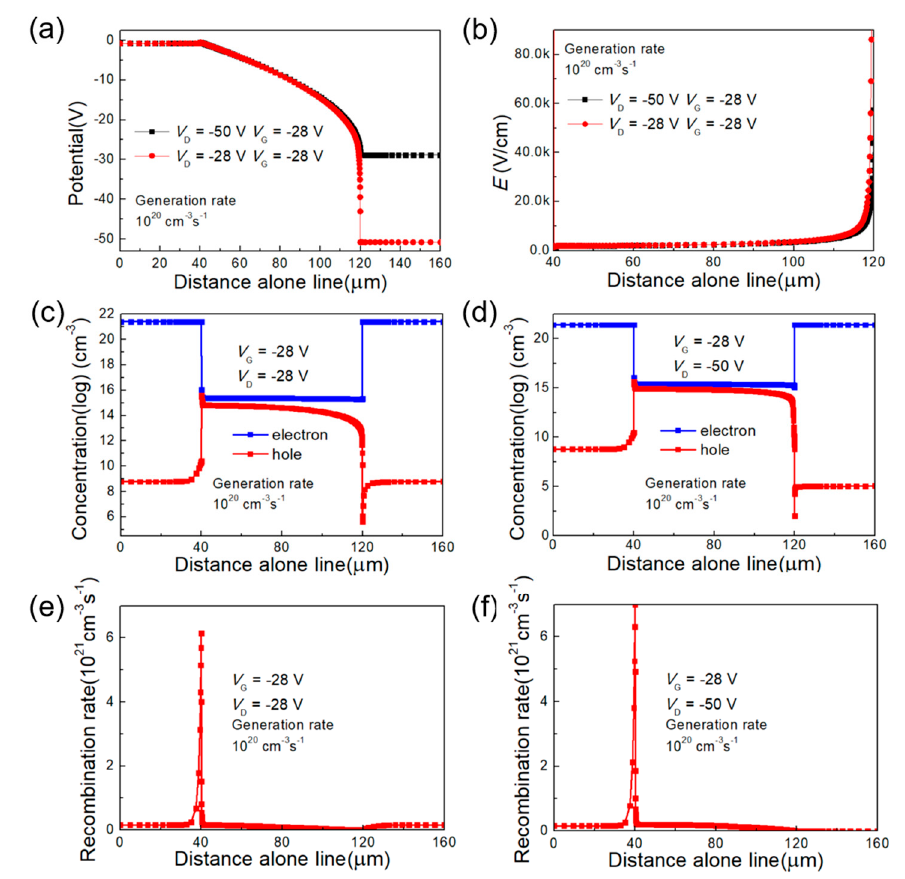
Figure 6. Cross-section data of surface potential ( a ), electrical field ( b ), charge concentration ( c , d ) and recombination rate ( e , f ) in the channel at different bias conditions under illumination.